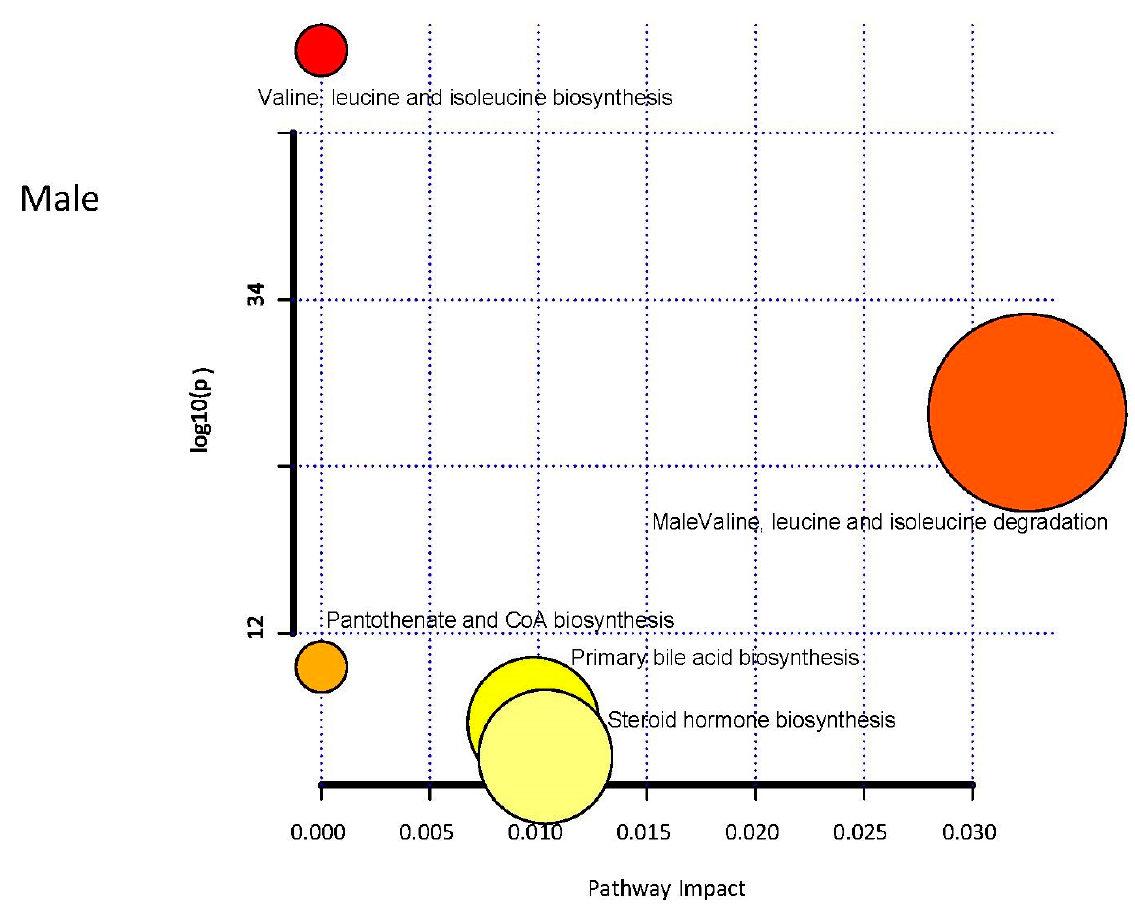
Figure 5. Metabolic pathway analysis for male patients. The x -axis represents the pathway impact, while the y -axis represents the − log ( p ). The analyzed pathway showed the metabolic network reprogramming of male ischemic patients with detailed impact.